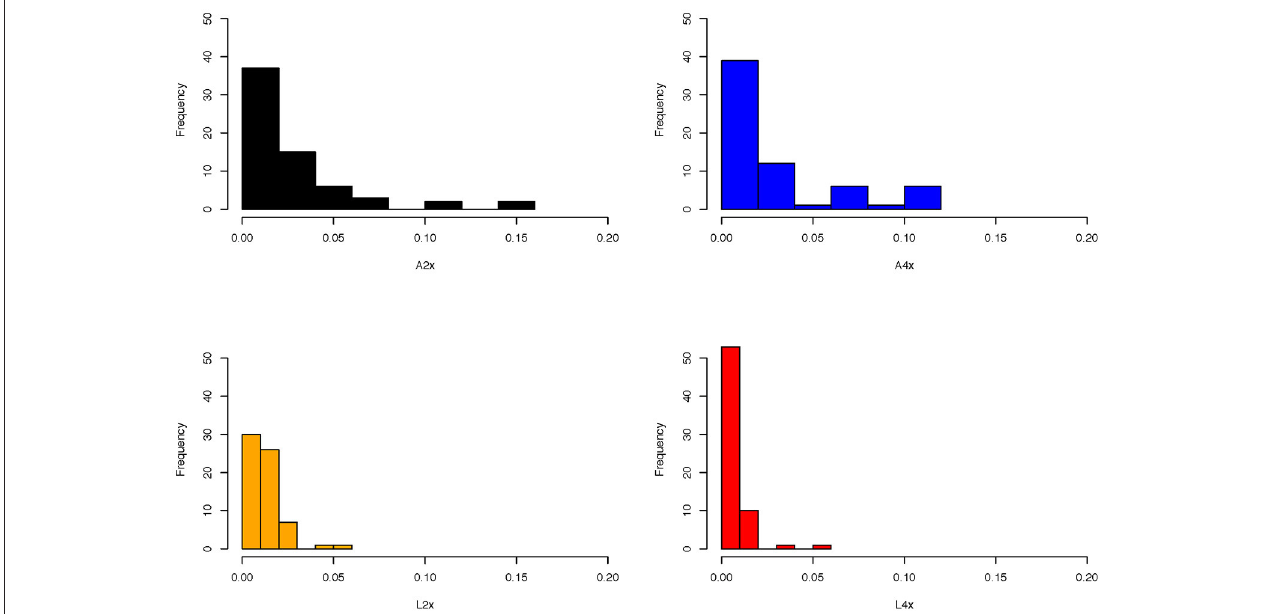
FIGURE 2 | Allele frequency distributions of SRK alleles identified in diploid and tetraploid populations of A. lyrata and A. arenosa using 454 pyrosequencing. Note that there appears to be an excess of intermediate frequencies in A. arenosa (A2x = diploids; A4x = tetraploids), with more of a skew toward low frequency alleles in A. lyrata , particularly in